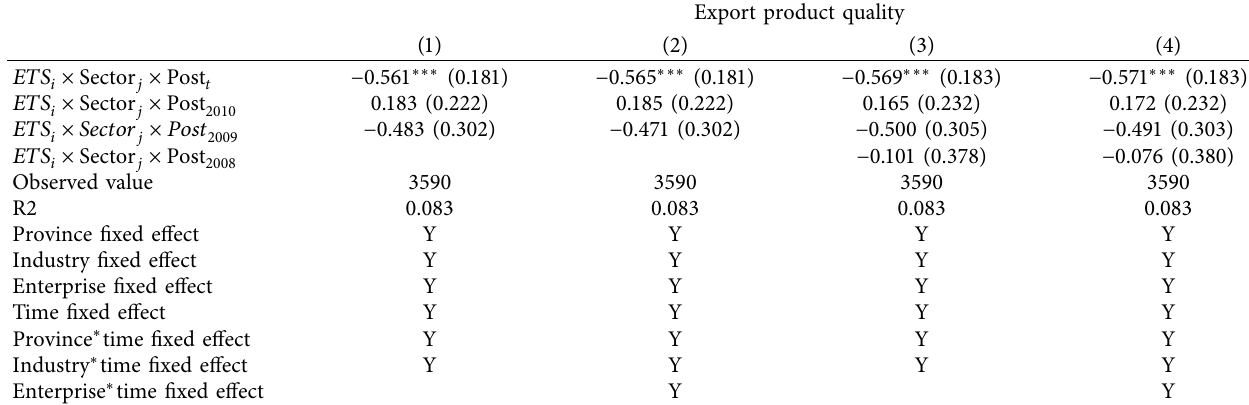
Table 3: Placebo test.